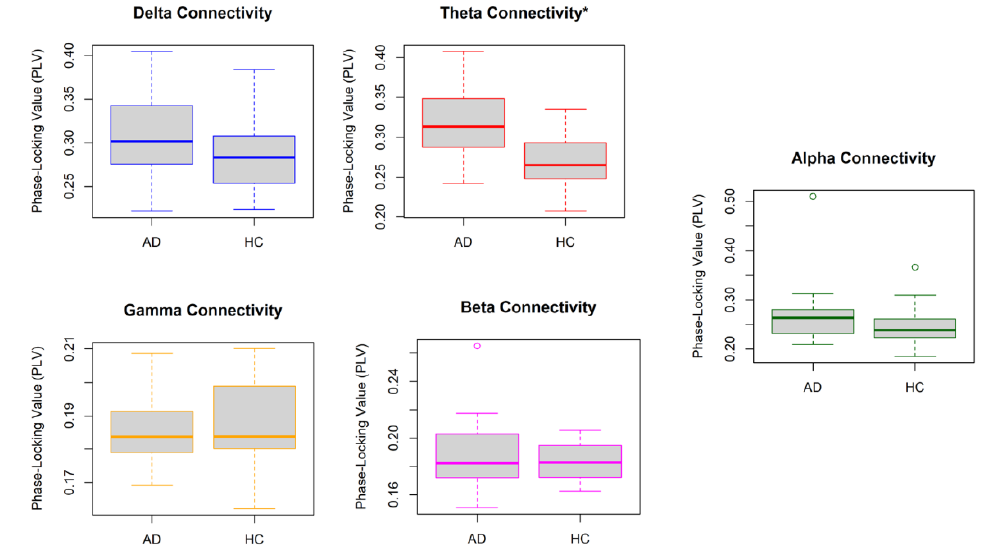
Figure 3. The average PLVs obtained from all connectivity pairs for the five frequency bands (global connectivity). Plots marked with * indicate a statistically significant difference ( p < 0.05) between AD patients and HCs.